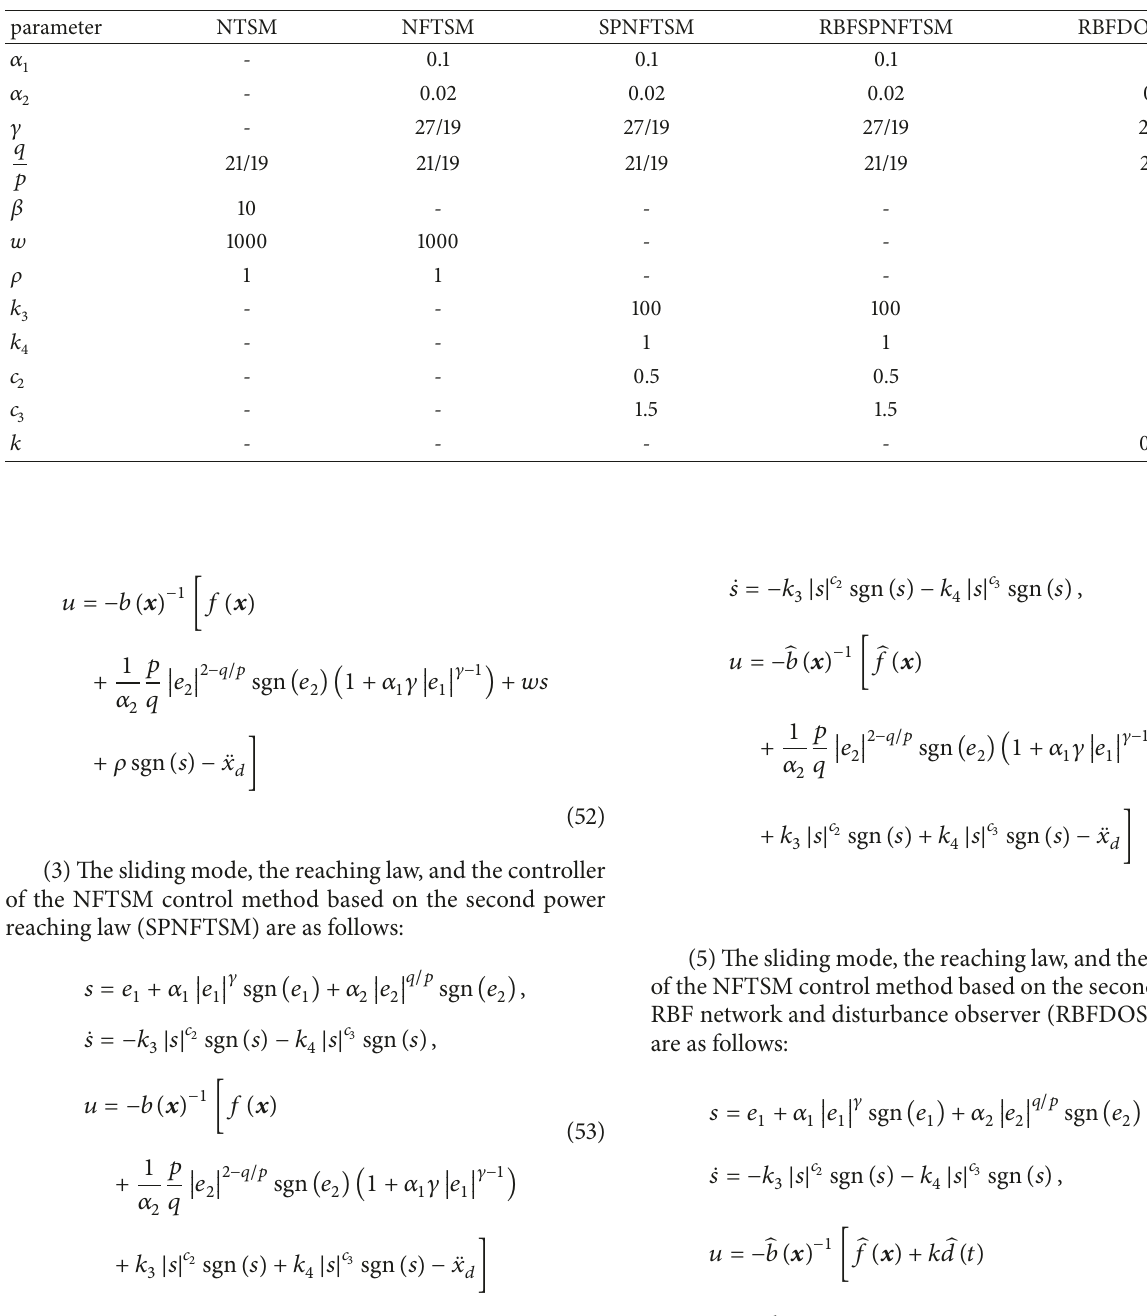
Table 2: Controller